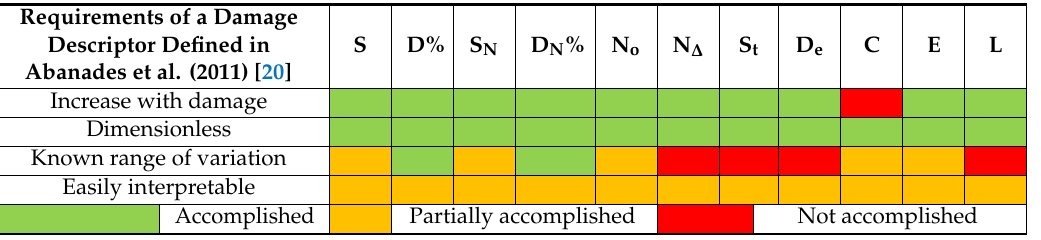
Table 2. Synthesis of damage descriptors and accomplishment of the recommended requirements defined in Abanades et al. (2011)